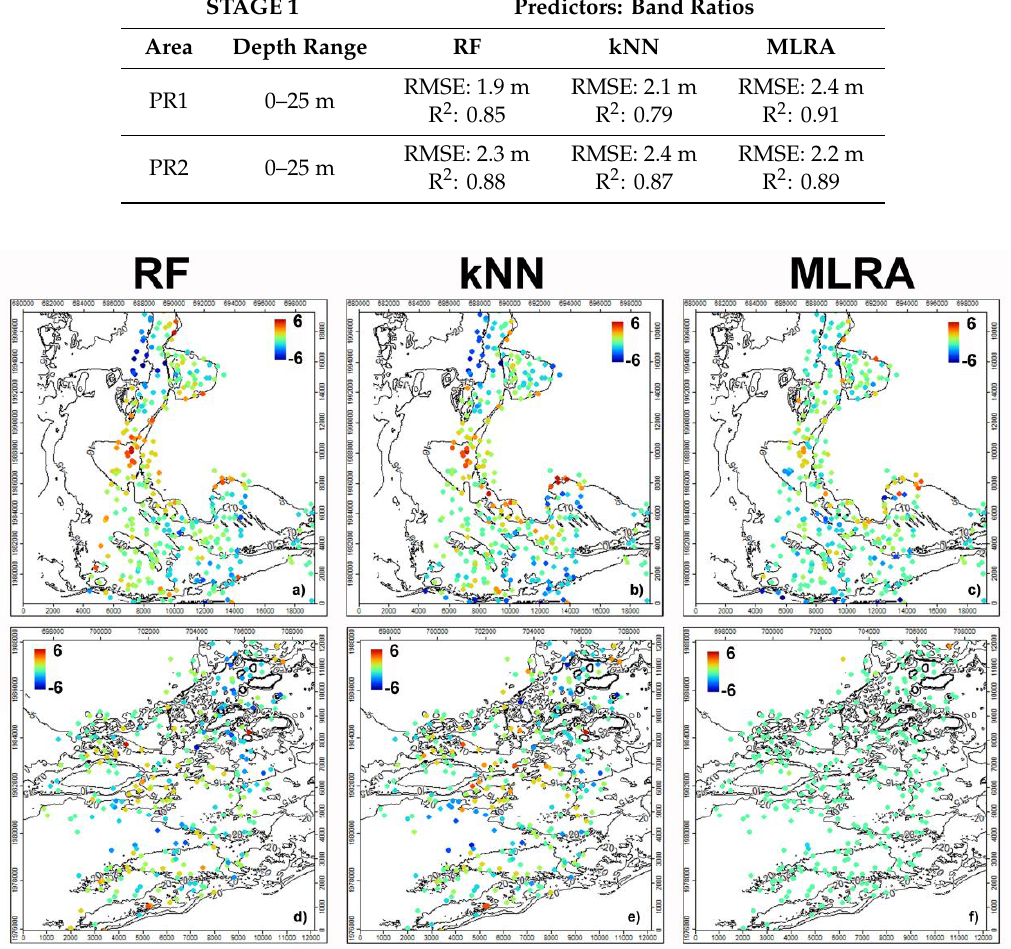
Figure 4. Training data points for both sub-areas PR1: (a),(b),(c) and PR2: (d),(e),(f) with residual depth values resulting from RF (a),(d) , kNN (b),(e) , and MLRA (c),(f) . Table 2. Bathymetry prediction accuracy (RMSE and correlation coefficient R 2 with reference bathymetry) for stage 1.